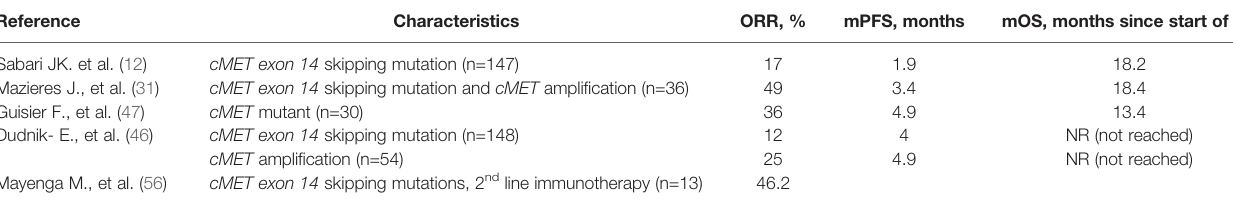
TABLE 3 | Ef fi cacy of ICIs in NSCLS with c-MET